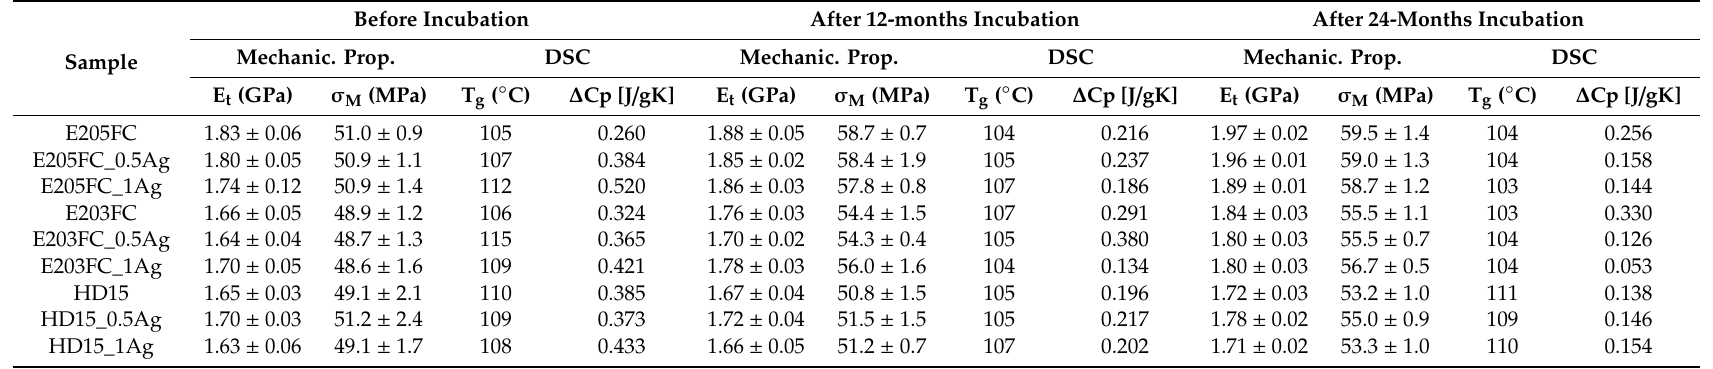
Table 1. Young modulus, tensile strength, glass transition temperature and specific heat capacity of the pure polymers and polymers containing 0.5 wt % and 1.0 wt % of silver nanoparticles